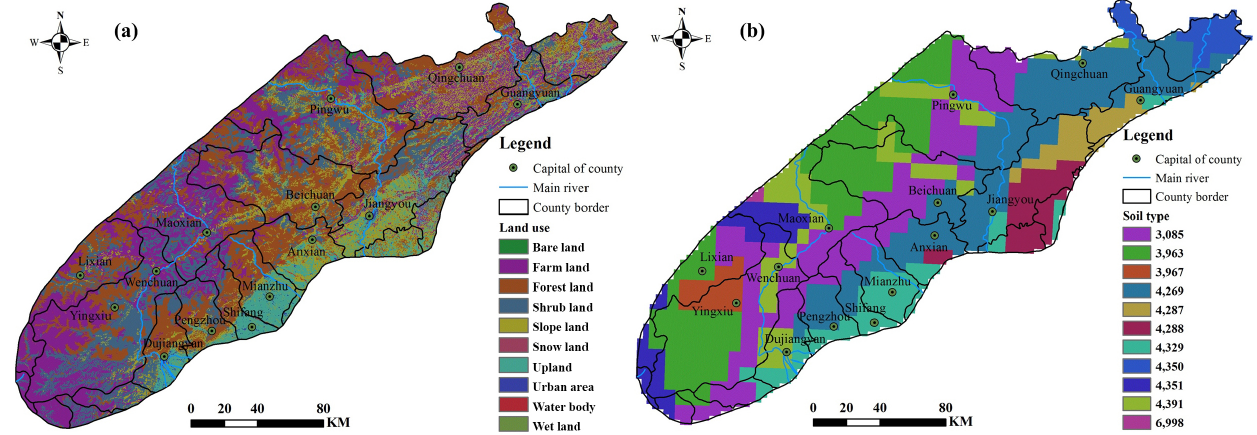
Figure 5. (a) Distribution of land use; (b) distribution of soil type.